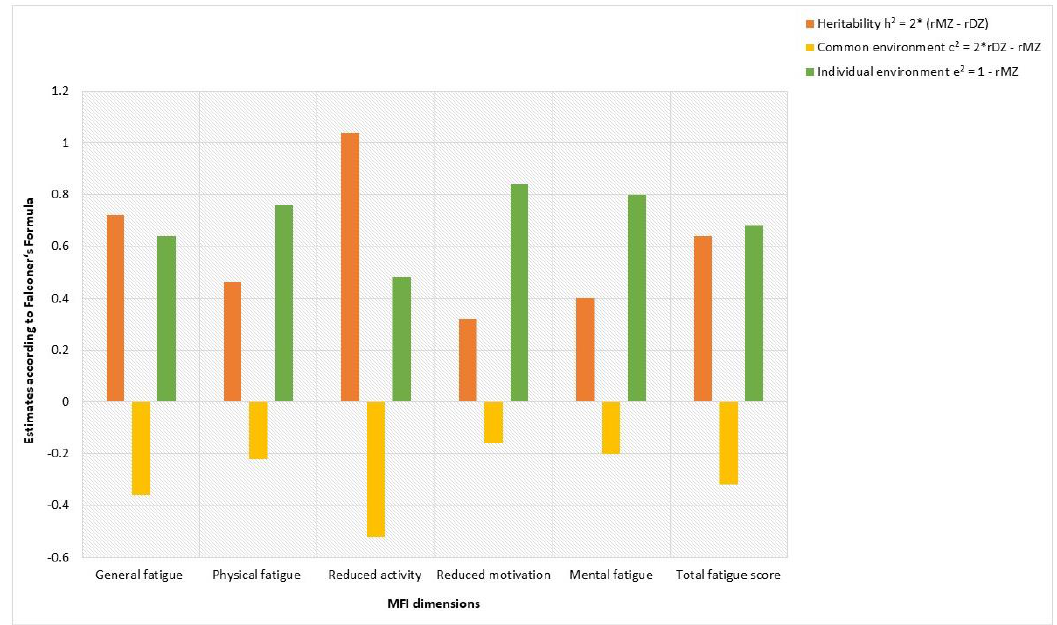
Figure 2. Estimates of heritability (h 2 ), common (c 2 ) and individual environmental (e 2 ) effects on fatigue dimensions of twin pairs ( n = 24) concordantly experiencing increased fatigue since the COVID- 19 pandemic according to the Falconer’s formula. Notes: MFI = Multidimensional Fatigue Inventory.